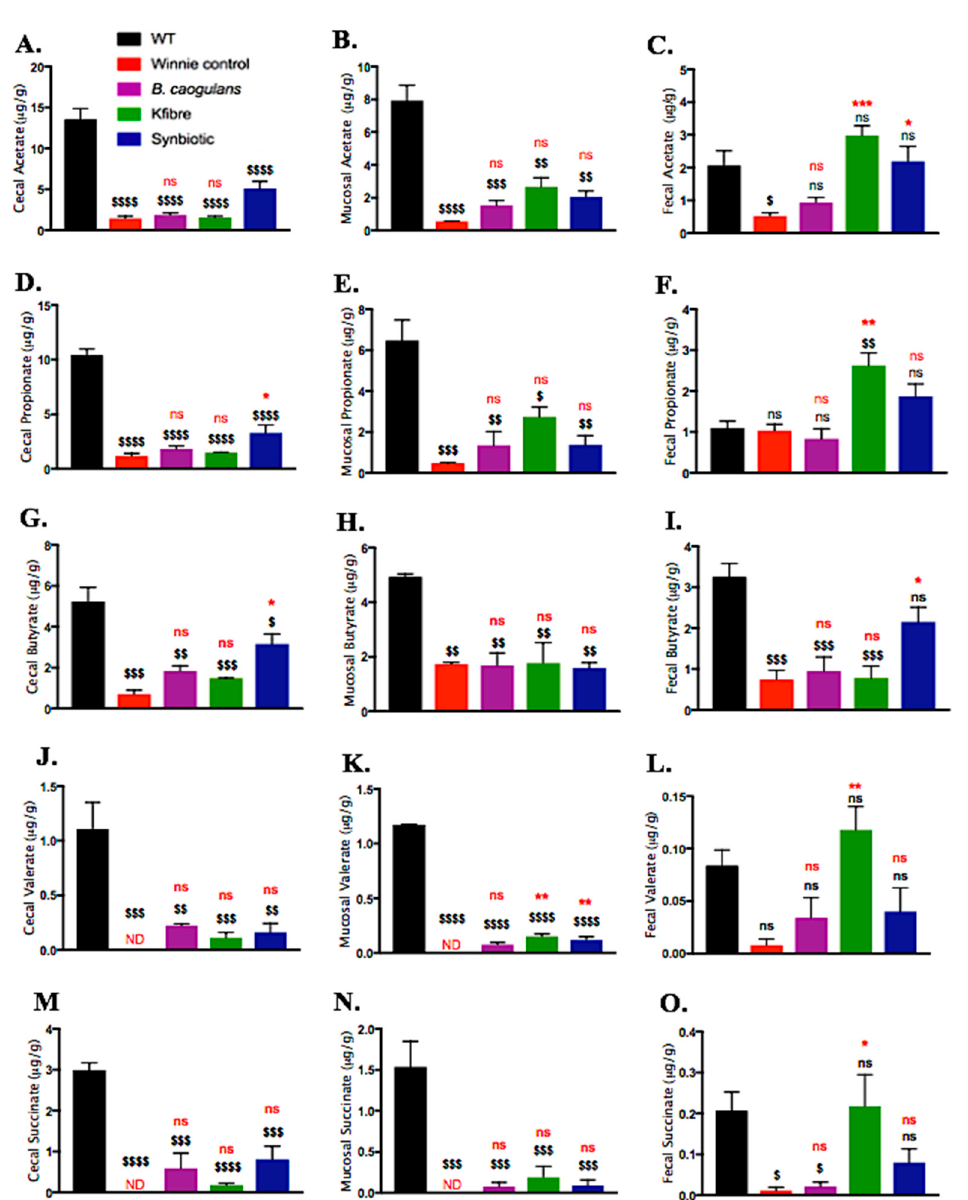
Figure 8. Effects of B. coagulans spores, PSCF and Synbiotic in modulating SCFA concentrations in caecal, mucosal-associated and faecal contents in Winnie vs. Wild-type (WT) mice. Caecal-acetate ( A ), propionate ( D ), butyrate ( G ), valerate ( J ), succinate ( M ); mucosal-associated acetate ( B ), propionate ( E ), butyrate ( H ), valerate ( K ), succinate ( N ) and faecal-acetate ( C ), propionate ( F ), butyrate ( I ), valerate ( L ), succinate ( O ). Statistical significance among groups evaluated by one-way ANOVA. * p < 0.05, ** p < 0.01, *** p < 0.001, ns vs. Winnie-control group and $ p < 0.05, $$ p < 0.01, $$$ p < 0.001, $$$$ p < 0.0001, ns vs. WT group. Data expressed as mean ± SEM ( n = 5 per group). ns = non-significant, ND = not